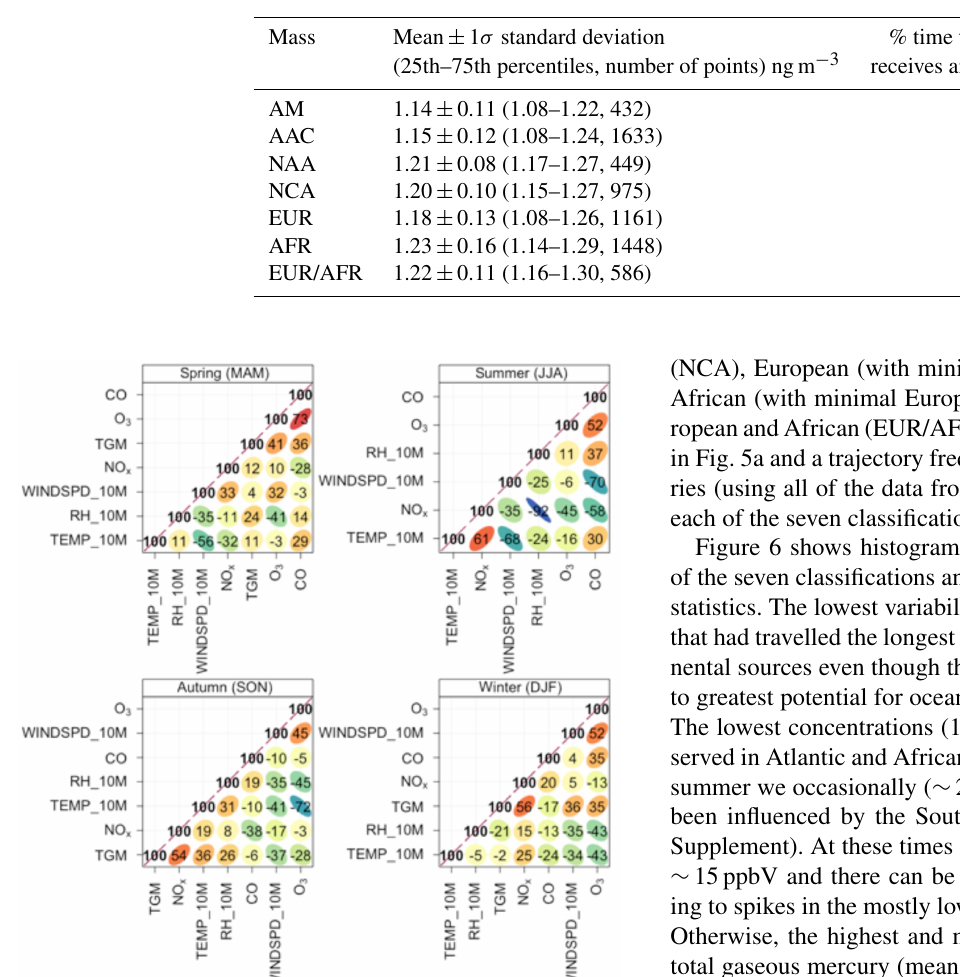
Table 2. Statistics for the individual air mass classified data.